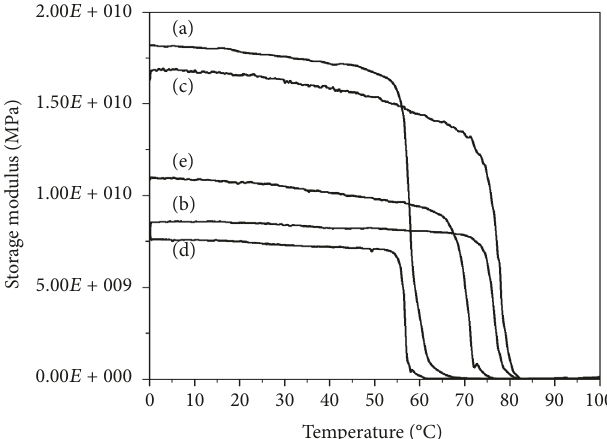
Figure 6: Storage modulus of the PLA-PNSP biocomposites: (a) neat PLA, (b) 5% wt. PNSP defatted, (c) 7.5% wt. PNSP defatted, (d) 5% wt. PNSP untreated, and (e) 7.5% wt. PNSP untreated.